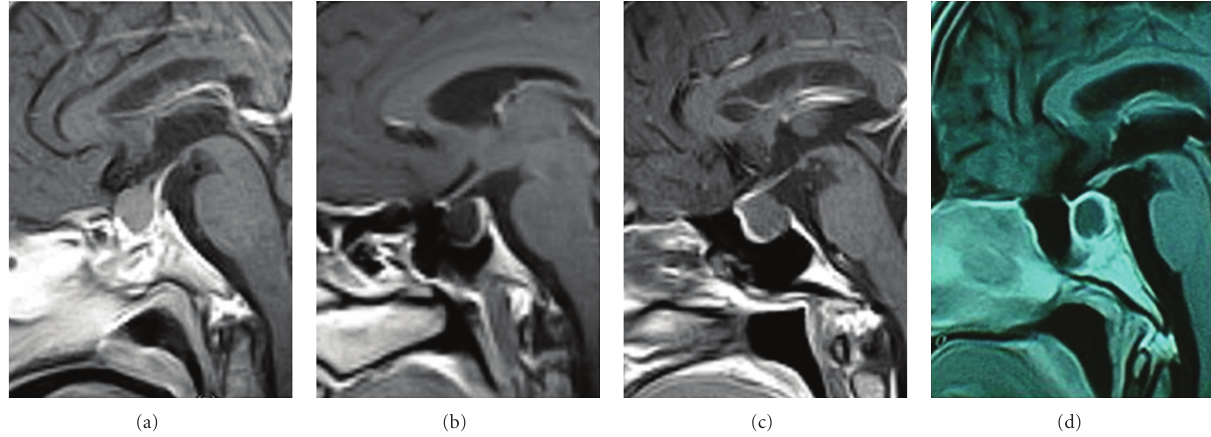
Figure 4: Enhanced middle sagittal image: relation between RCC and adenohypophysis at 4 di ff erent sites. (a) RCC anterosuperior to adenohypophysis. (b) RCC anterior to adenohypophysis. (c) RCC posterior to adenohypophysis. (d) RCC surrounded by